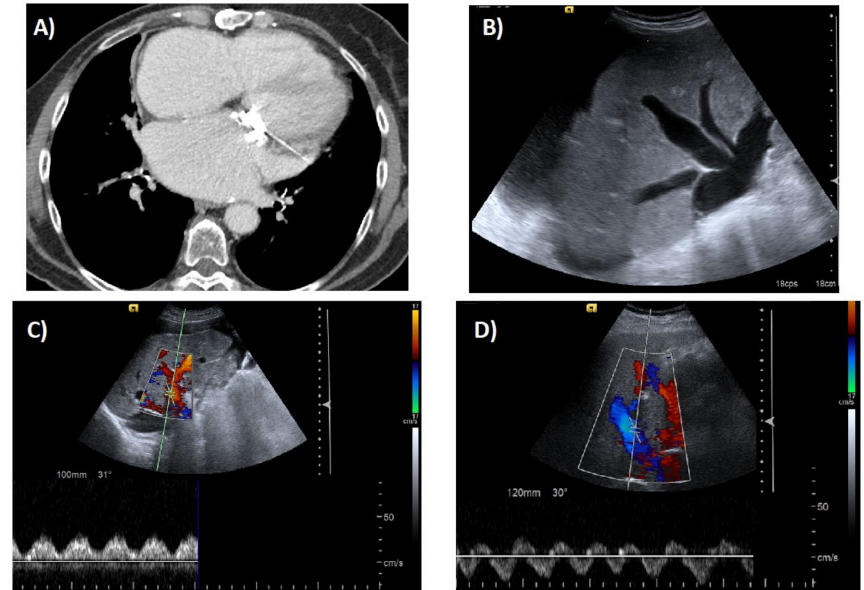
Figure 2. ( A ) Cardiomegaly in a patient with ischemic cardiomyopathy. ( B ) Dilated suprahepatic vein in the same patient. ( C ) Doppler ultrasound in one of the dilated suprahepatic veins. ( D ) Hepatopetal flow in the portal vein highly modulated by the cardiac